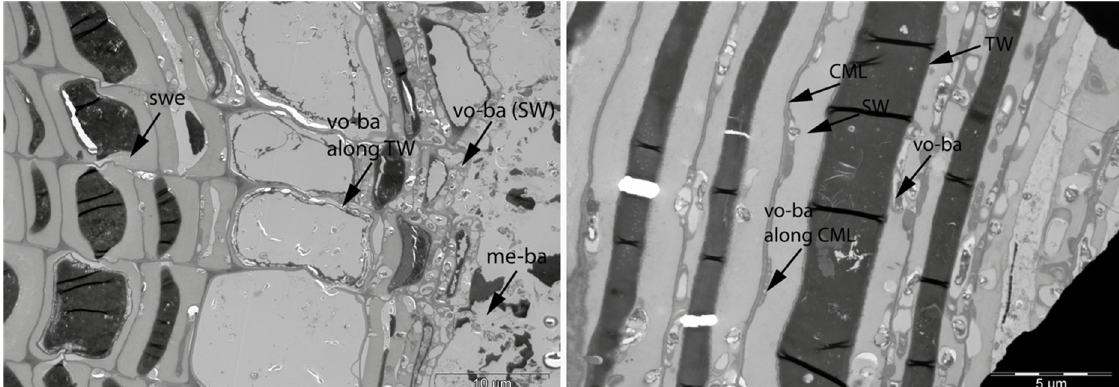
Figure 26. Sample 12. TEM: swelling and loosening of secondary walls of thick-walled cells (swe) and voids created by bacteria in secondary cell wall of thick- and thin-walled cells. Bacteria are aligned along compound middle lamella and tertiary wall, creating tunnels with concentric rings, characteristic of tunnelling bacteria. Based on the appearance, the presence of erosion bacteria is possible. Bacteria were able to digest all cell wall layers and phenolic lumen content (me-ba).